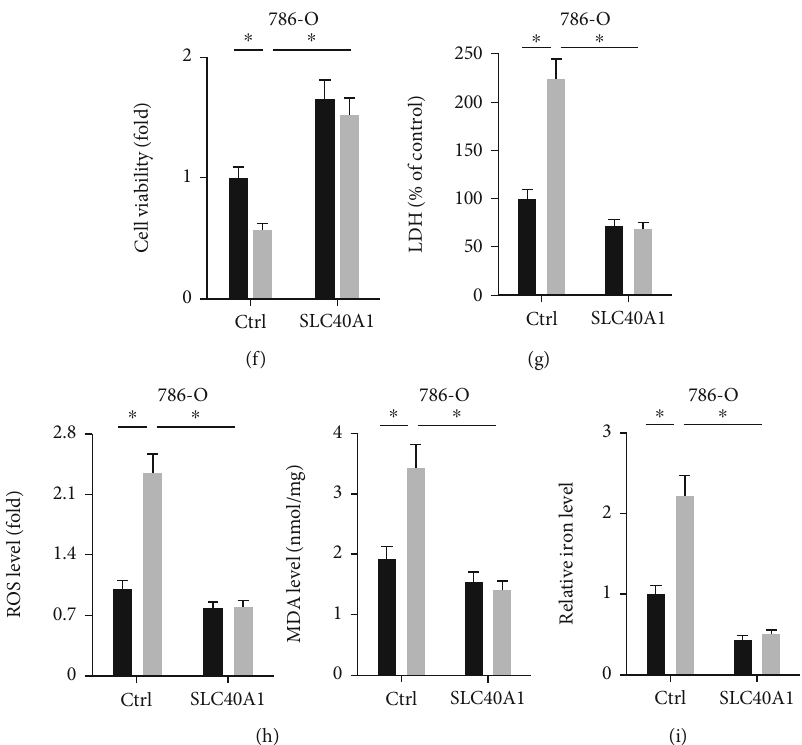
Figure 4: Overexpression of miR-4735-3p induces ferroptosis through downregulating SLC40A1. (a) The complementary sequences of miR-4735-3p in SLC40A1 3 ′ -UTR. (b) Relative SLC40A1 protein level in human ccRCC tissues and adjacent normal tissues. (c and d) Relative SLC40A1 protein and mRNA levels in 786-O cells treated with the miR-4735-3p mimic, inhibitor, or respective controls. (e) Relative luciferase activity in HEK293T cells transfected with the miR-4735-3p mimic and SLC40A1 3 ′ -UTR. (f) Relative viability in SLC40A1-overexpressed 786-O cells treated with the miR-4735-3p mimic or mimic control. (g) Relative LDH releases in 786-O cells. (h) ROS level and MDA content in 786-O cells. (i) Relative iron level in 786-O cells. N = 6 per group. All data were expressed as the mean ± SD ; ∗ P < 0 : 05 was considered signi fi